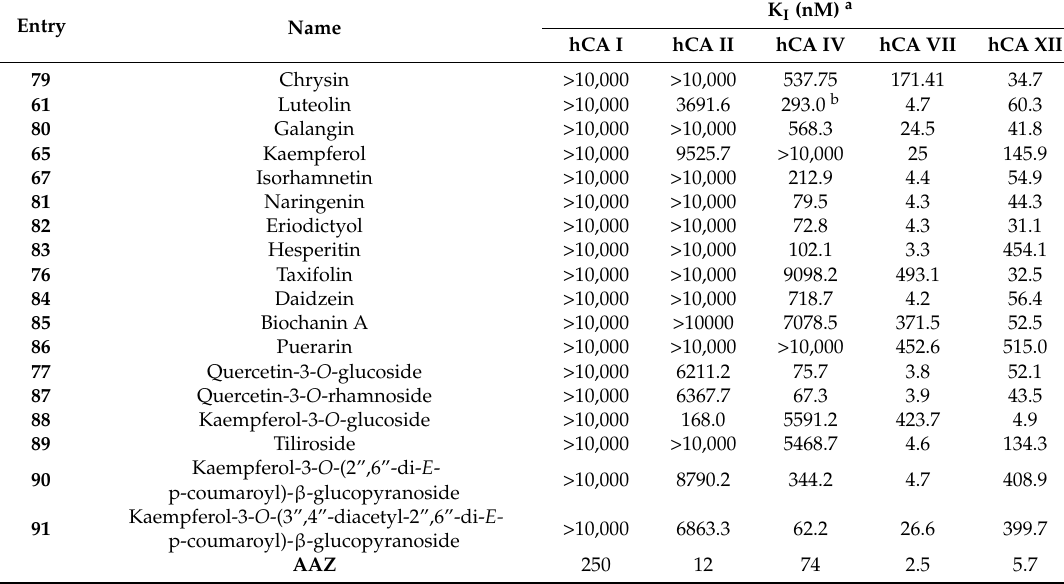
Table 10. Inhibition data of human CA isoforms hCA I, II, IV, VII and XII with flavonoids 59 , 63 , 66 , 74 , 75 , 76 – 88 reported here and the standard sulfonamide inhibitor acetazolamide ( AAZ ) by a stopped flow CO 2 hydrase